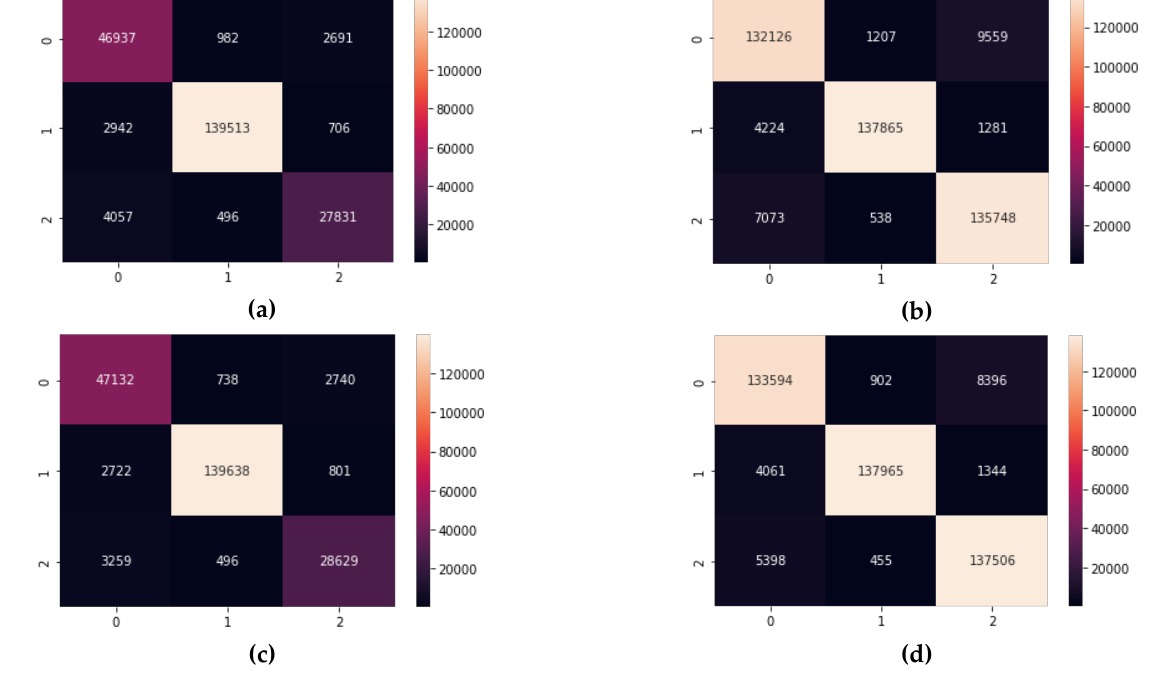
Figure 8. The Confusion Matrices for the tree-based algorithms, listed as: (a) DT in setting 1; (b) DT in setting 2; (c) RF in setting 1; (d) RF in setting 2.